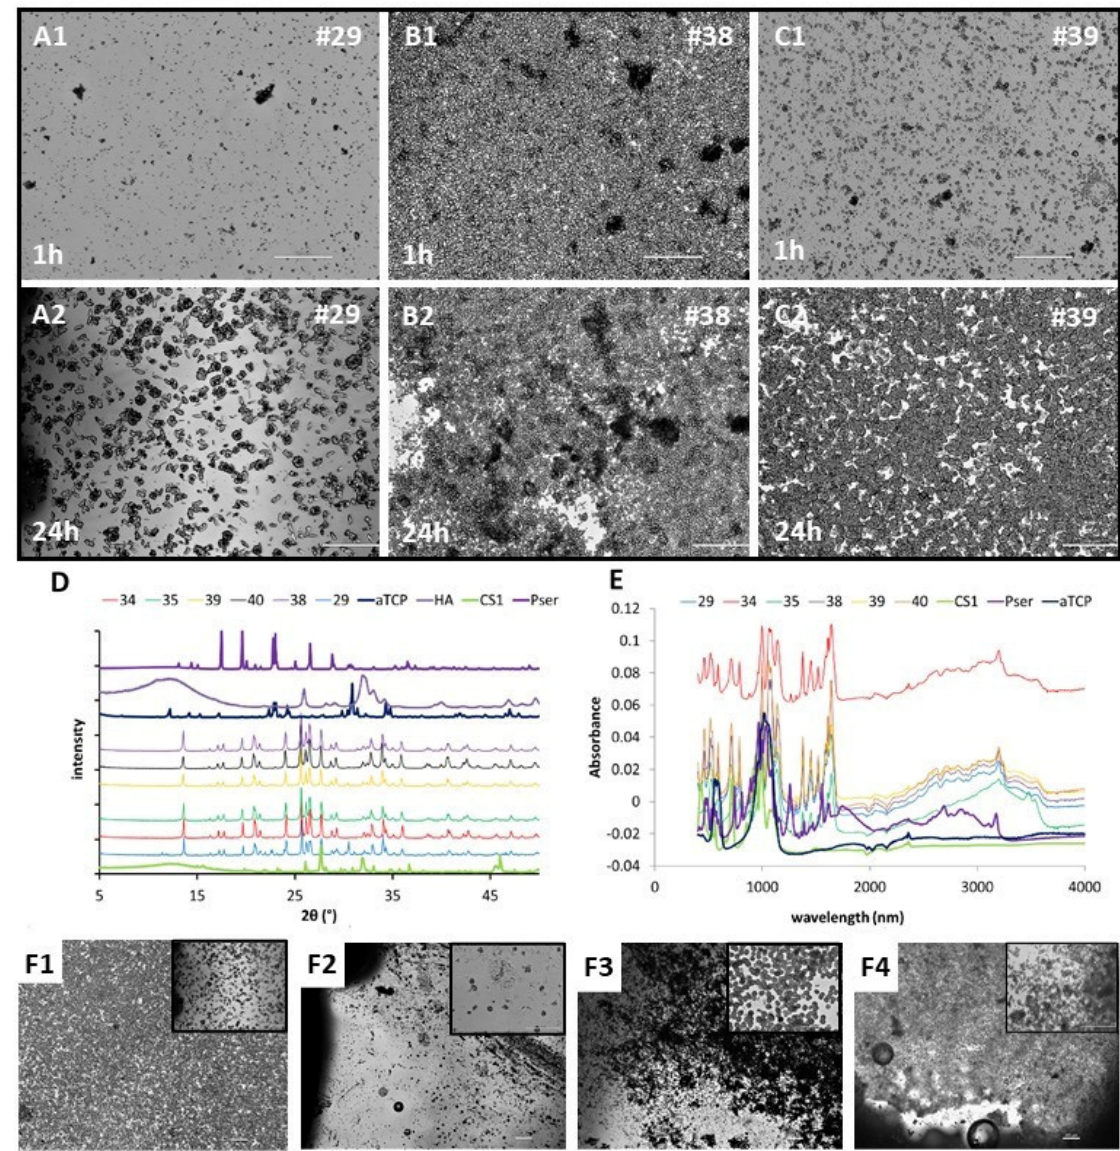
Figure 4. Light microscopy images and chemical analysis of precipitants. ( A1 – C1 , A2 – C2 ) Precipitant formation/density and effect of immersion time. ( D ) XRD and ( E ) FTIR spectra of dried precipitant powders, collected after sample immersion for 24 h. ( F ) Light microscopy images of precipitants for the four most interesting formulations, #29 ( F1 ), #34 ( F2 ), #35 ( F3 ), and #38 ( F4 ), immersed in